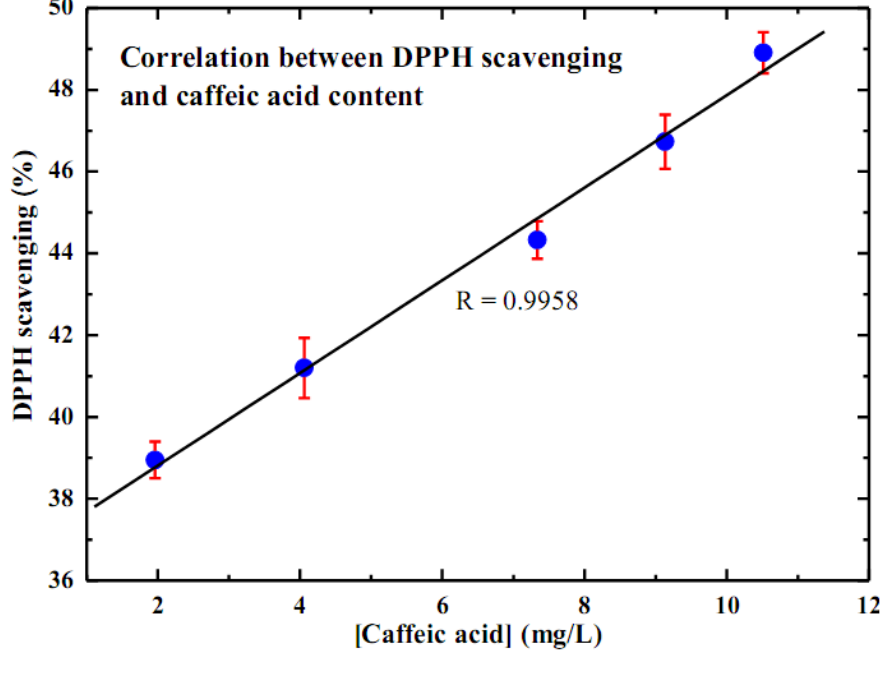
Figure 4. Correlation between %DPPH·scavenging and caffeic acid